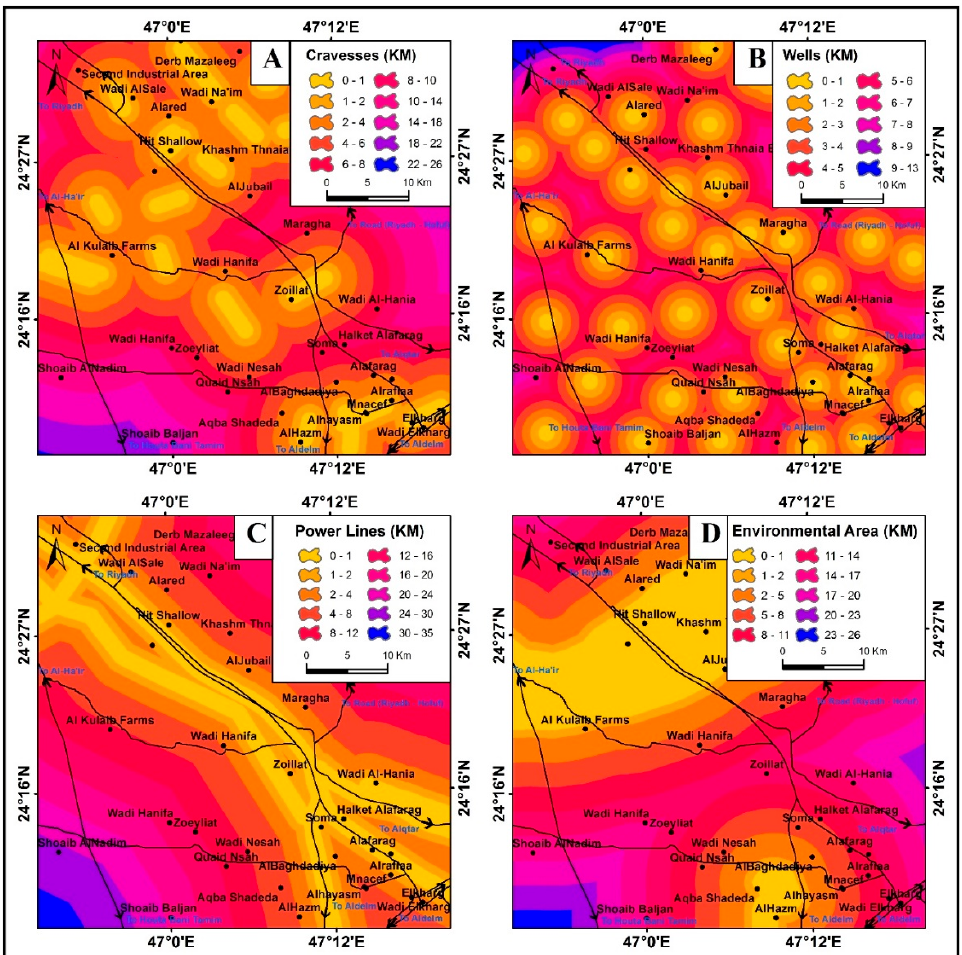
Figure 8. The distance ranges (part 3): ( A ) crevasses / faults, ( B ) water sources, ( C ) power lines, ( D ) environmental areas. Table 2. Category classification and suitability for the different criteria affecting the rural–urban continuum between Ar Riyadh and Al Kharj.